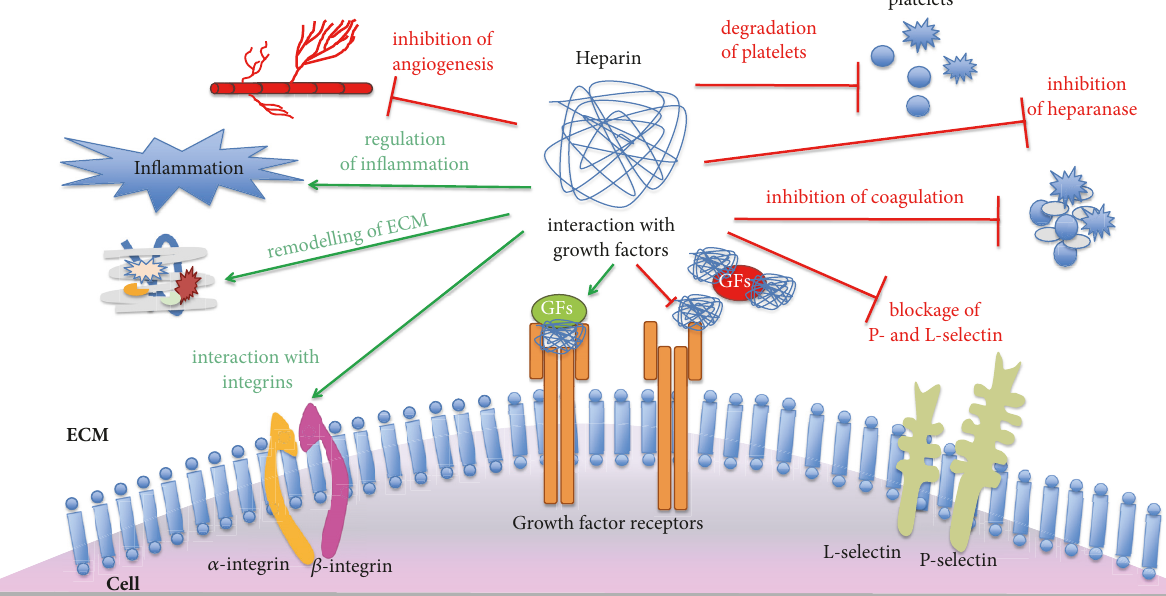
Figure 1: Bio l ogica l e ff e cts of h e parin . Heparin has inhibitory and activating roles in molecular and cellular mechanisms. It has a role in degradation of platelets, inhibition of coagulation, and angiogenesis. It also acts as a heparanase inhibitor and blocks P- and L-selectin to interactwith platelets and prevents metastasis. Moreover, it interacts with ECM proteins and enhances remodeling of the ECM. It is involved in inflammatory processes and regulates inflammation. Heparin interacts with integrins and growth factors. However, in some growth factor signaling pathways it may have inhibitory as well as activating effects. For instance, it interacts with factors such as FGF, TGFB1, and MK and regulates the signaling positively. In contrast, it also interacts with FGF and HGF and regulates the signaling negatively (ECM: extracellular matrix; FGF: fibroblast growth factor; and HGF: hepatocyte growth